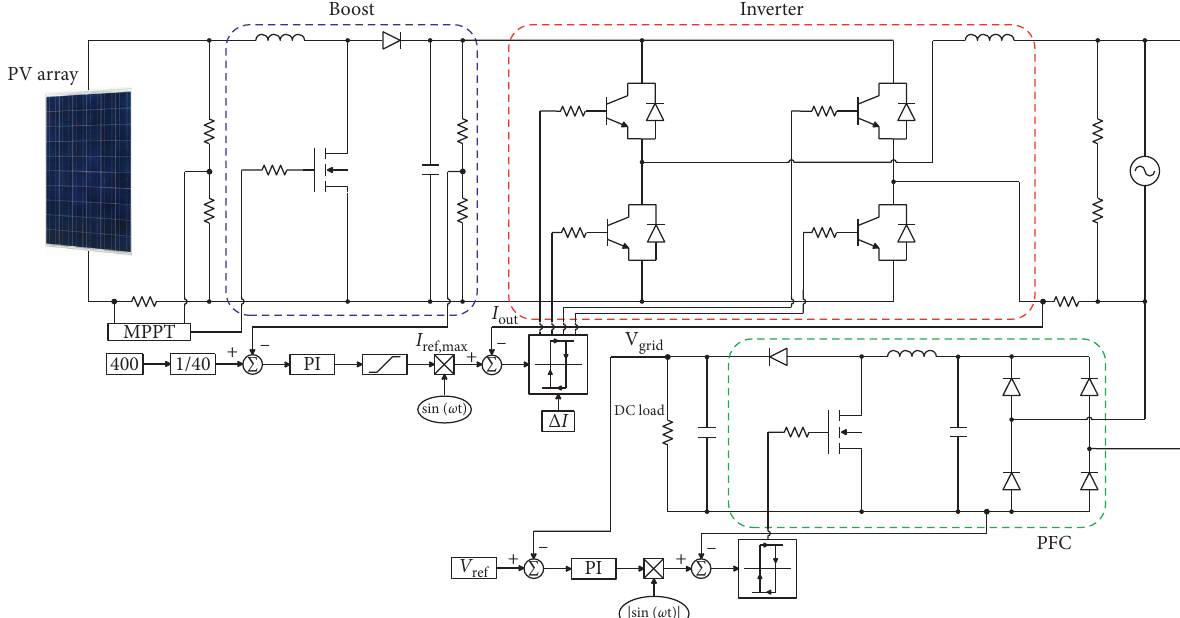
Figure 3: On-grid PV chain (syst1) implemented in “Saber” simulation